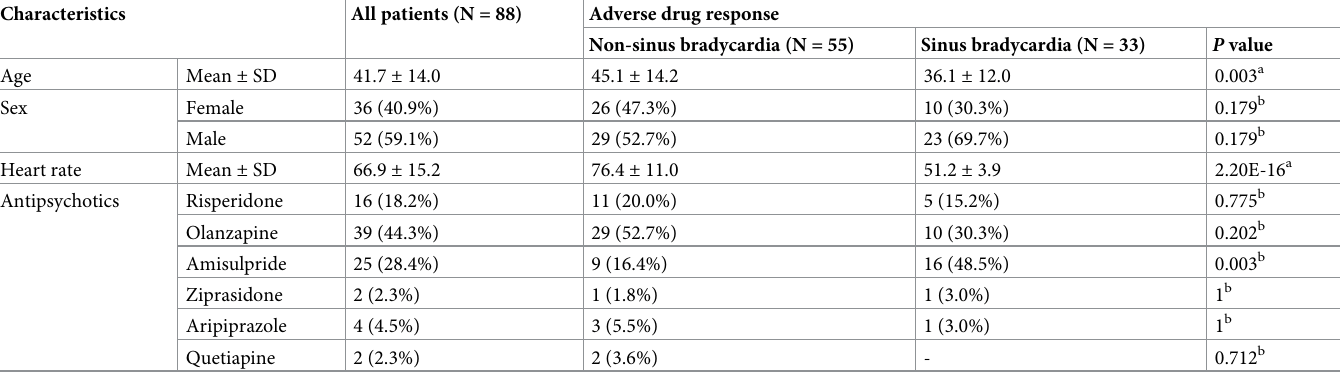
Table 1. Demographic characteristics of the study patients. Characteristics